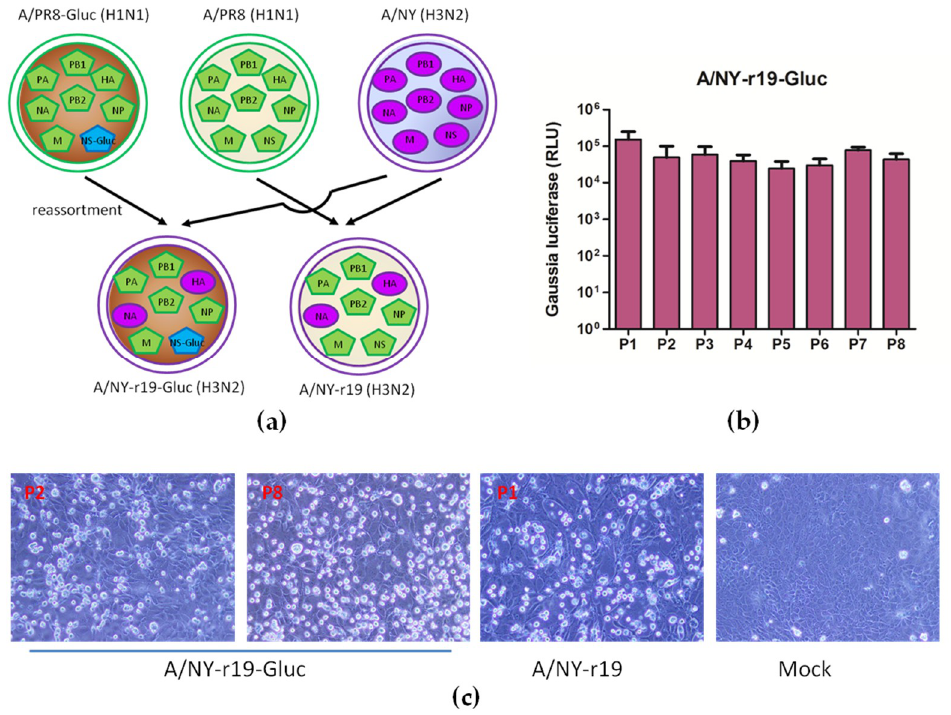
Figure 3. Generation of reporter influenza A subtype H3N2 virus encoding the HA and NA genes of wildtype NY virus, in a backbone comprising the six internal genes of PR8. ( a ) Diagram of reassorment for generating reporter A / NY-r19-Gluc virus. A / NY-r19 virus was generated in parallel as control. ( b ) MDCK cells were infected with NY-r19-Gluc virus from serial passage experiments in MDCK cells (passages 1 to 5) at a MOI of 0.01. At 60 h p.i., luciferase assays were performed. ( c ) MDCK cells were mock-infected or infected with NY-r19 and NY-r19-Gluc virus of the indicated passages, respectively, at a MOI of 1. Cytopathic e ff ects were observed at 60 h p.i. using Olympus inverted phase contrast microscope IX73 (magnification 200 × ).